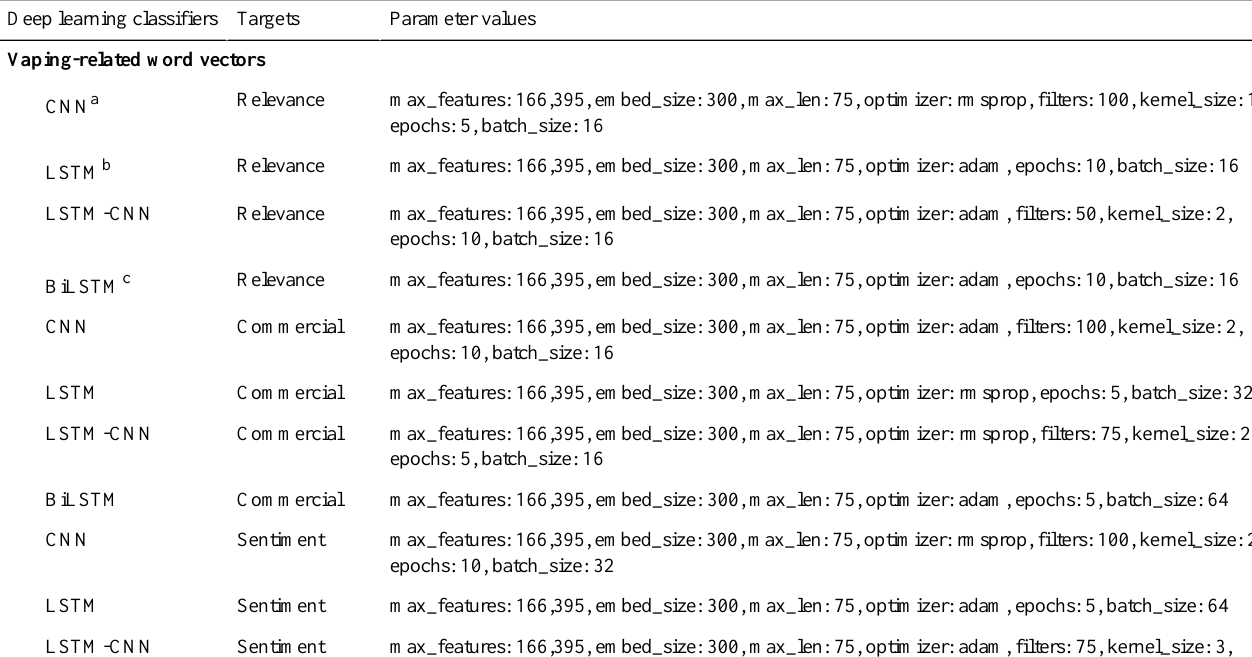
Parameter valuesTargetsDeep learning